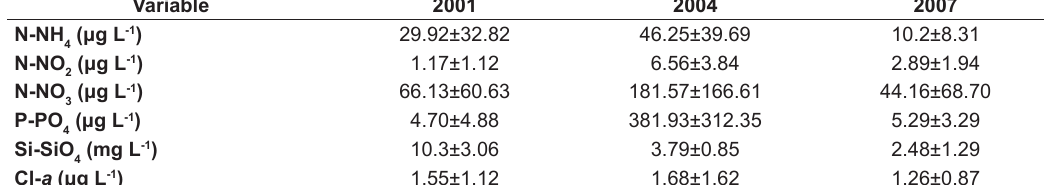
Figure 4. Inter-annual variability on the means and standard-deviations (a) and on the monthly variation (b) of the electrical conductivity during the three hydrological years. Table 1. Means and standard deviations of inorganic dissolved nutrients, chlorophyll -a , and electrical conductivity during the three hydrological years.